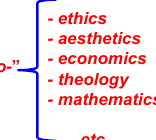
Figure 18. It is fashionable to speak of neuro-ethics, neuro-aesthet- ics, neuro-economics, etc., overlooking the essential role of inverse Bayes. Hence, the neuro-xxxx should be regarded as scientific mis-